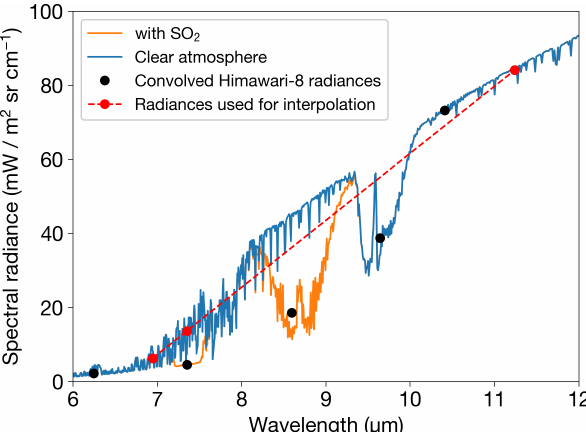
Figure B1. MODTRAN-6.0 simulations for atmospheres with and without SO 2 demonstrating how the interpolation procedure is used to estimate a clear-sky radiances from an atmosphere with SO 2 . Convolved radiances were derived using the Himawari-8 spectral response